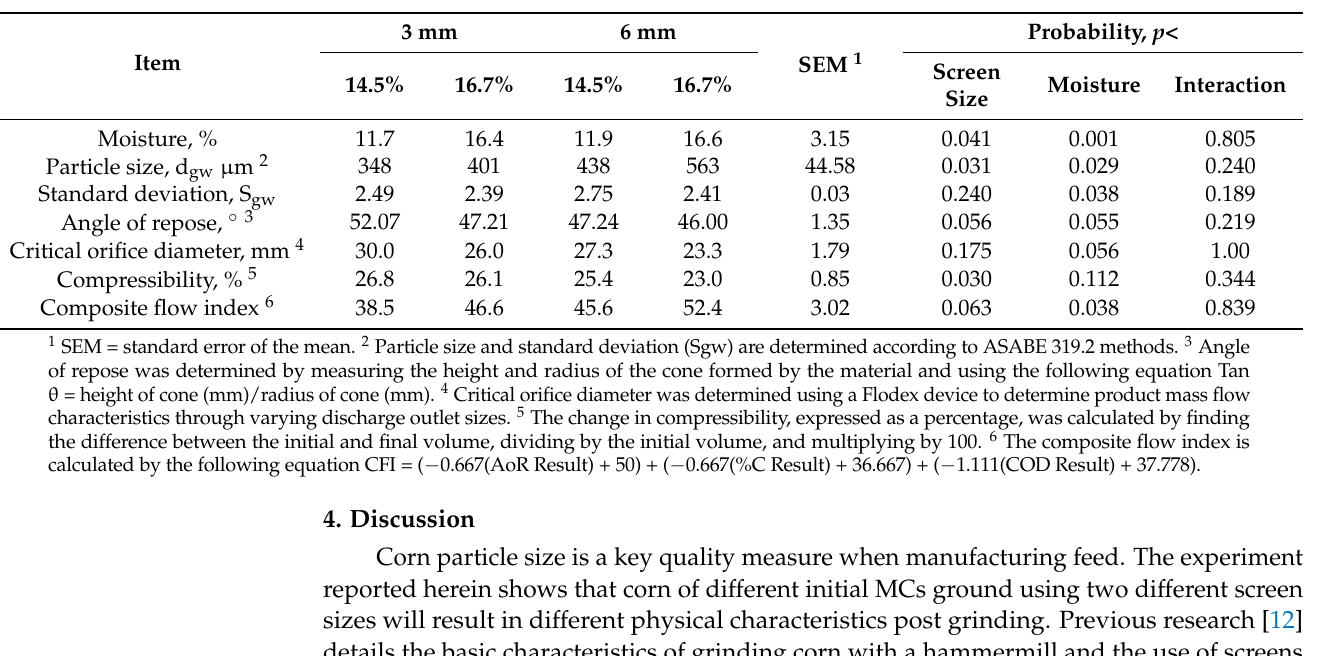
Table 1. Effect of initial corn moisture and screen size on physical characteristics of ground